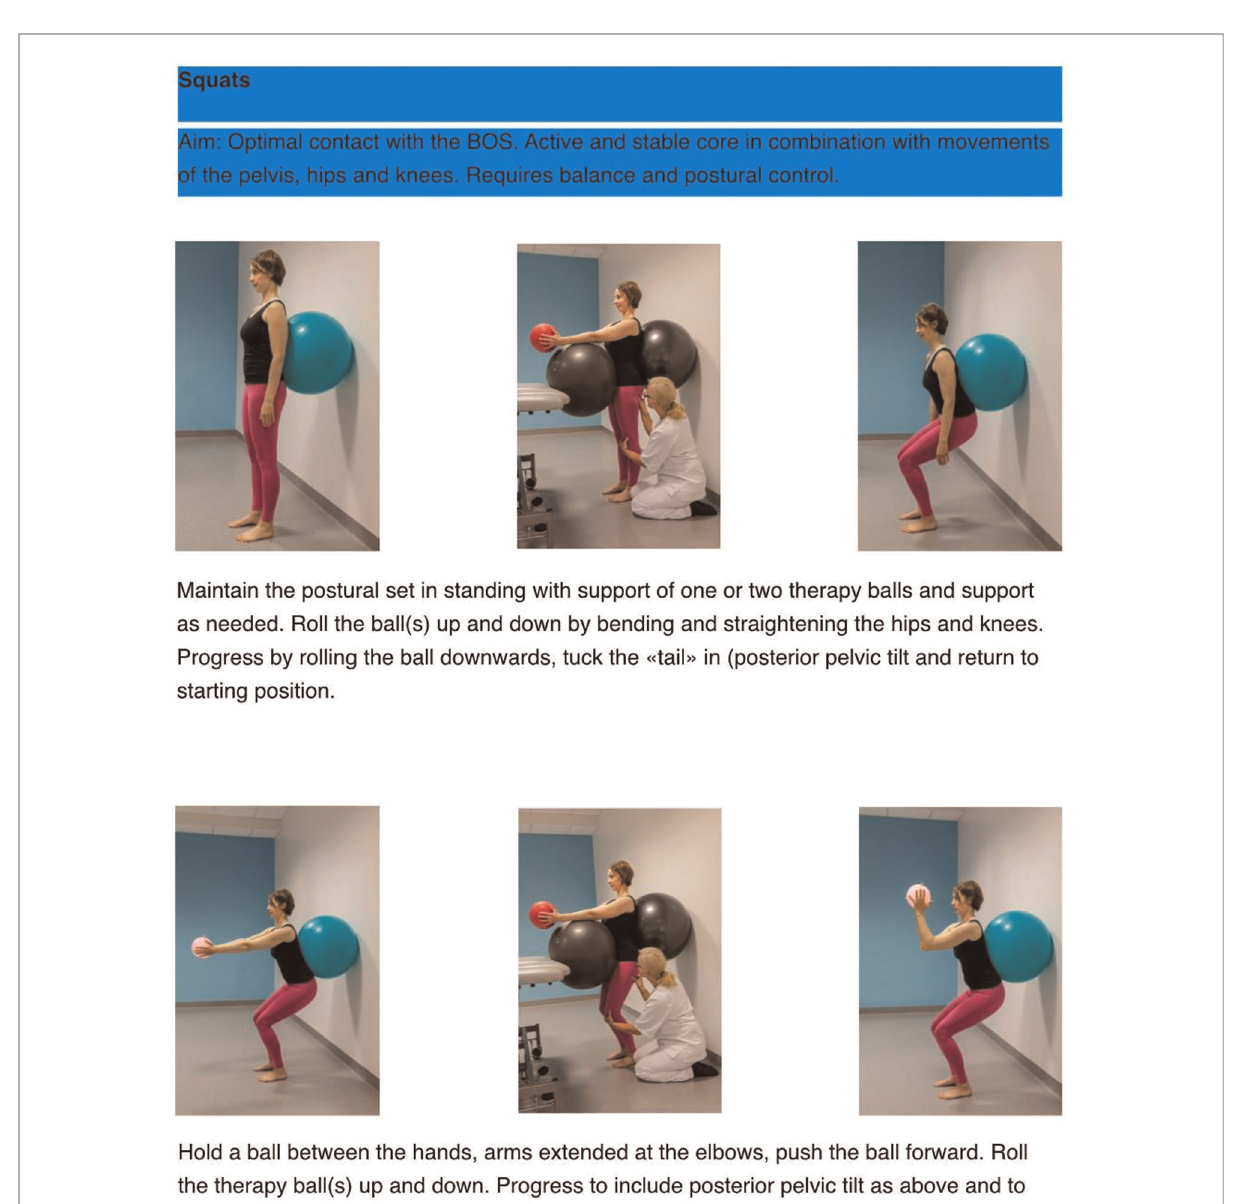
FIGURE 3 Example of exercise aiming for optimal adaptation to the base of support, an active core, activity in large muscle groups in a standing position while challenging postural control and